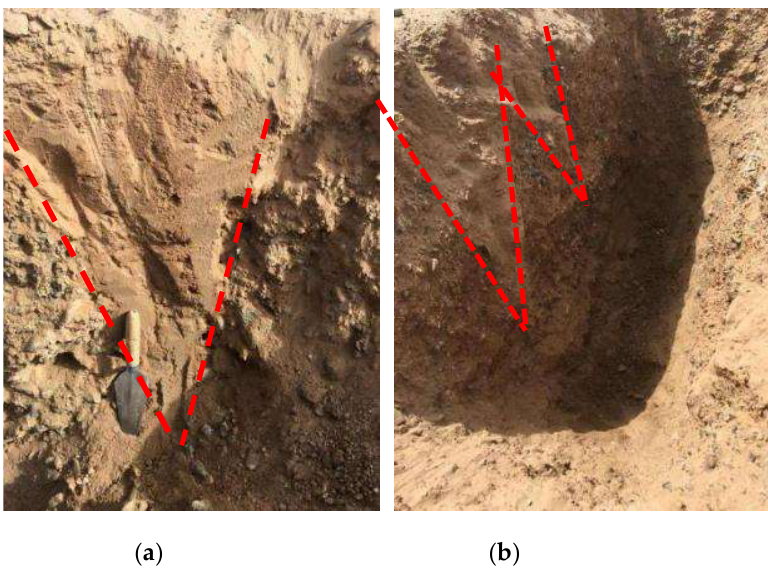
Figure 9. Soil profiles of two sample locations in the alluvial fan; both locations exhibit cross-sectional features shaped like the letter “V” approximately 20 cm below the surface with clear sand and gravel layers. ( a ) Field photo of sample location 1 in the Gobi near the Shuangdunzi; ( b ) field photo of sample location 2 near the Huangshuiba Reservoir.